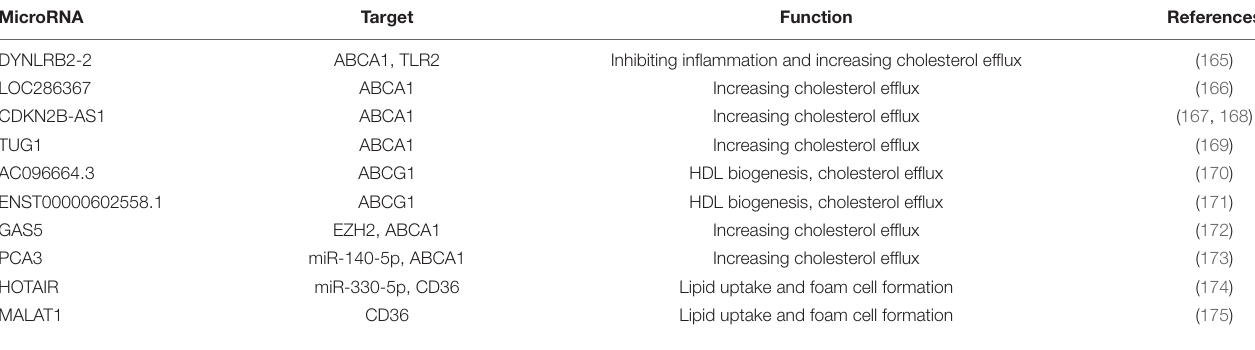
TABLE 2 | LncRNAs in the regulation of foam cells and lipid